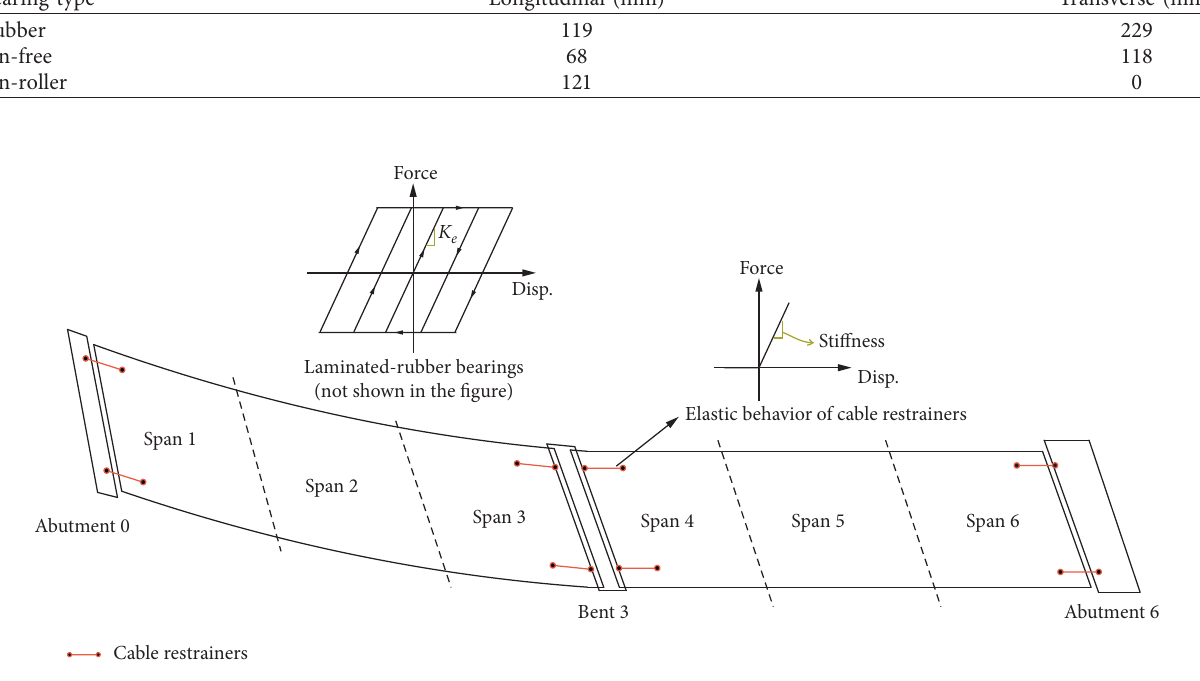
Figure 12: Layout of the cable restrainers for the Duxiufeng